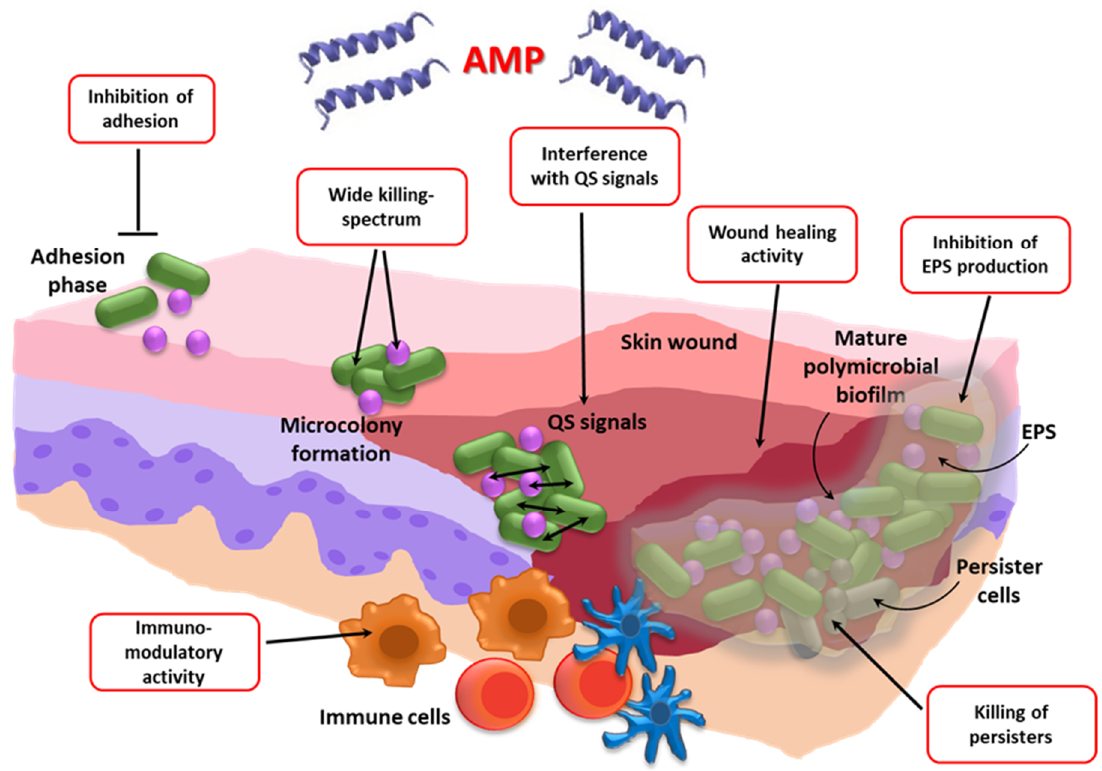
Figure 2. Formation stages of a polymicrobial biofilm in a skin wound taken as an example of mixed biofilm-associated infections. The red boxes show the multiple mechanisms of action proposed for the antibiofilm activity of AMPs. AMP: Antimicrobial peptide; QS: Quorum sensing; EPS: Extracellular polymeric substances.